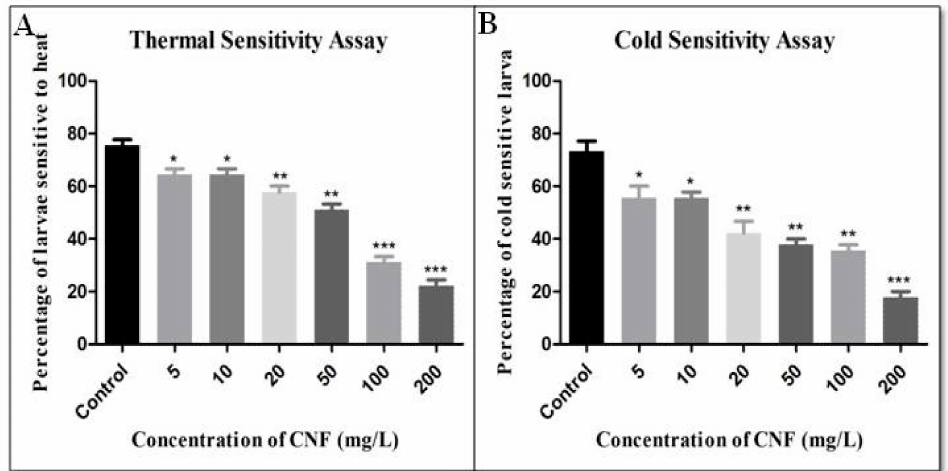
Figure 3. Temperature sensitivity assay to check the thermal sensing ability of the larva. ( A ) Heat sensitivity of larva treated with various concentrations of Wood-based Cellulose Nanofibrils (CNF). ( B ) Cold sensitivity of larva treated with various concentrations of CNF (* for p -value < 0.05, ** for p -value < 0.001, *** for p -value <